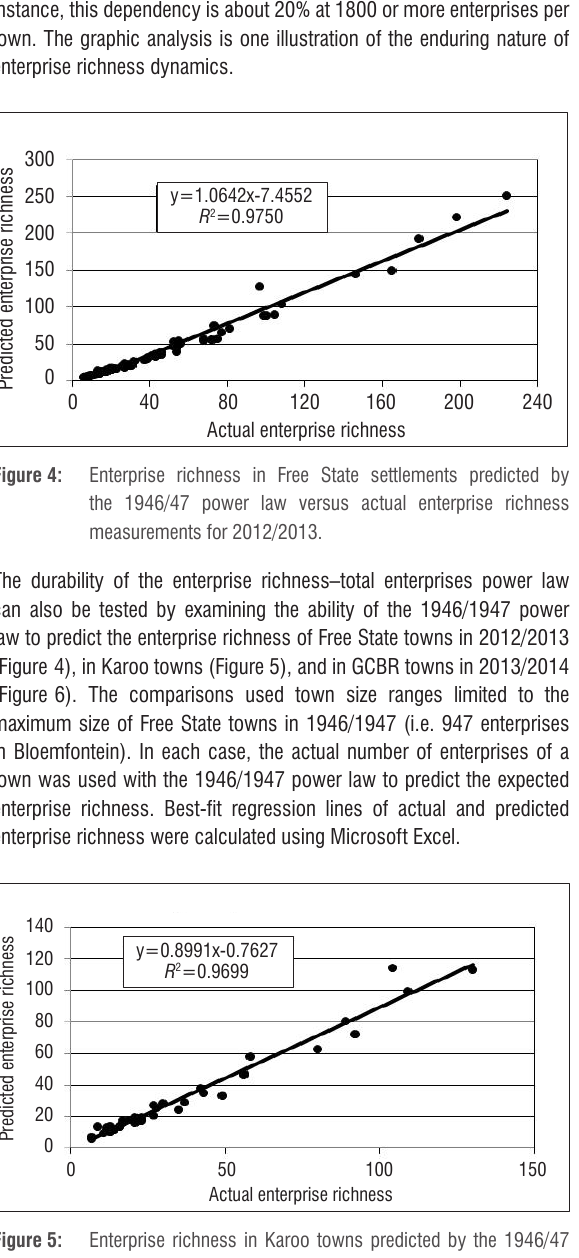
Figure 5: Enterprise richness in Karoo towns predicted by the 1946/47 power law versus actual enterprise richness measurements in recent